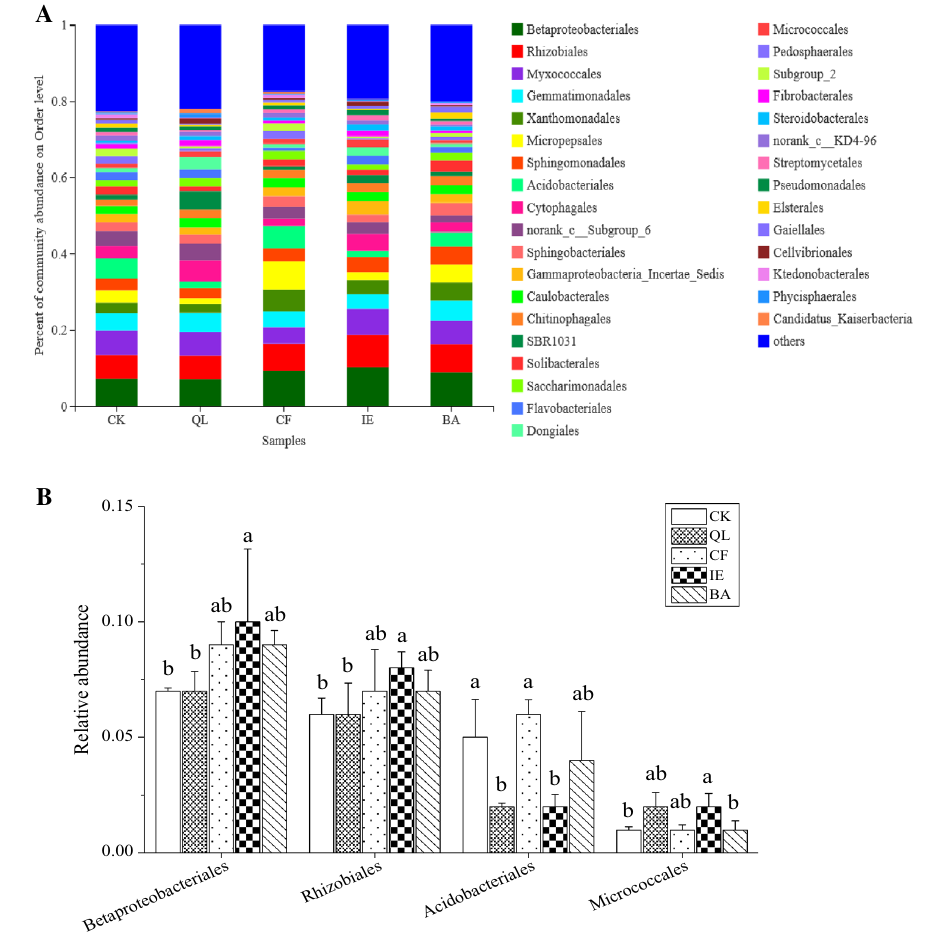
Figure 6. Relative abundance of bacterial orders of rhizosphere soil in continuous cropping lily. ( A ) The relative abundances of the bacterial orders of continuous cropping lily, and the taxonomic groups with an average relative abundance of < 1% were classified as other. ( B ) The relative abundances of four bacterial orders that were significantly higher or lower than the blank control (CK). QL quicklime, CF chemical fungicide, IE inoculation with earthworms, BA biocontrol